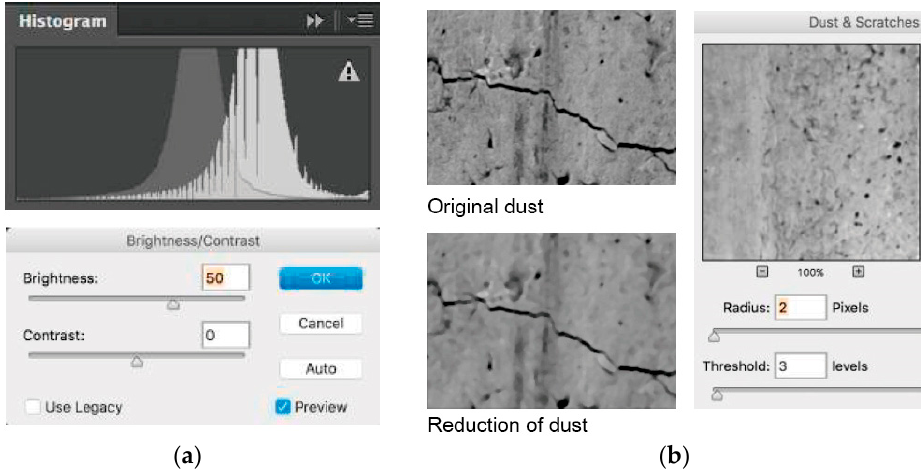
Figure 15. First enhancements: ( a ) correction of brightness: centered histogram; and ( b ) reduction of